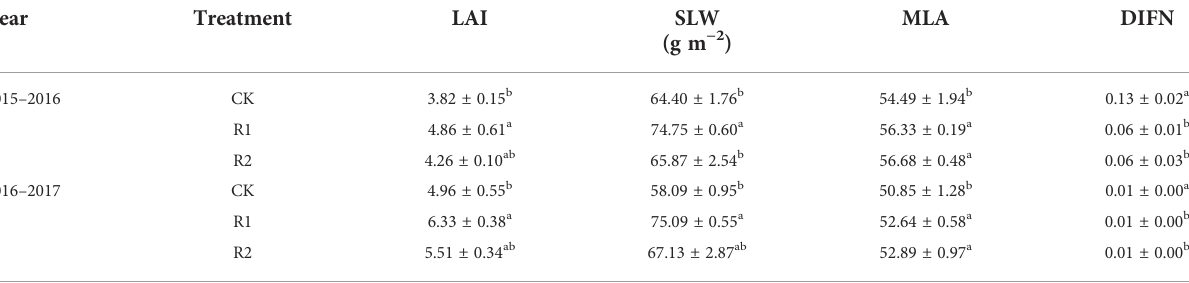
TABLE 2 Canopy morphology parameters of different treatments at the fl owering stage.